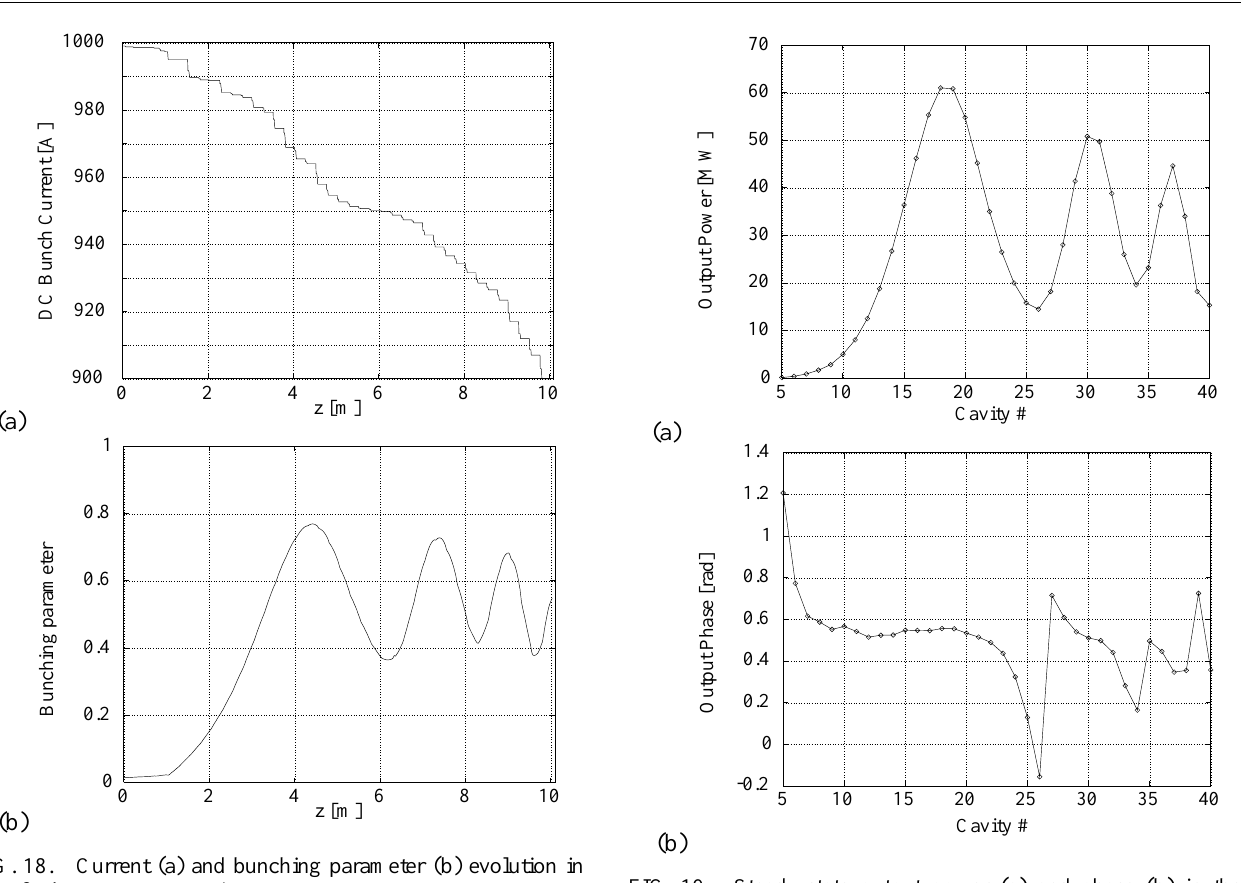
afterburner configuration. The lower limit in energy for a kiloamp scale RK-TBA seems to be approximately 2.5